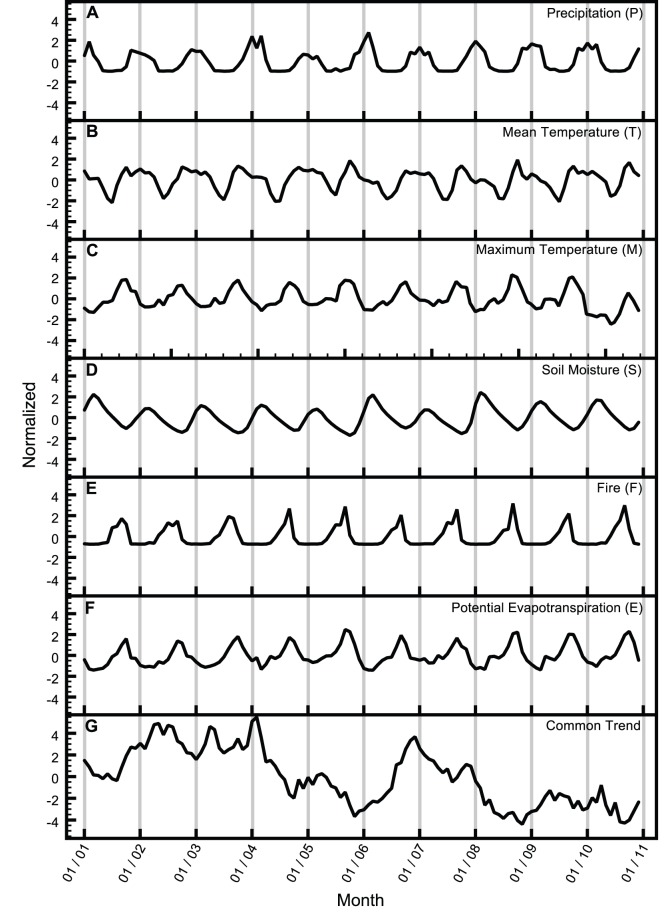
Normalized, area-weighted average explanatory variables used in the study.(A) precipitation, P; (B) mean temperature, T; (C) maximum temperature, M; (D) soil moisture, S; (E) fire, F; and (F) potential evapotranspiration, E. The common trend (G) for model II (FSPT) is shown for comparison.